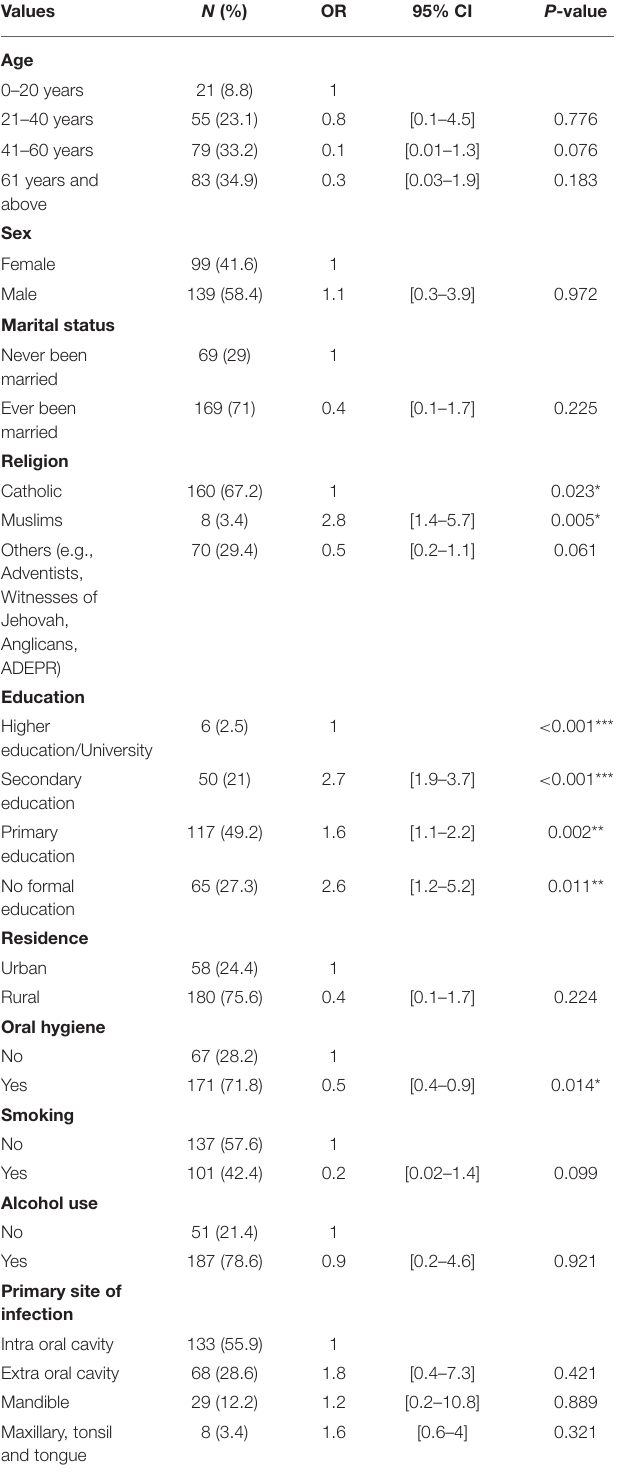
TABLE 3 | Association between the oral cancer adverse outcome and death and sociodemographic and behavioral factors. Values